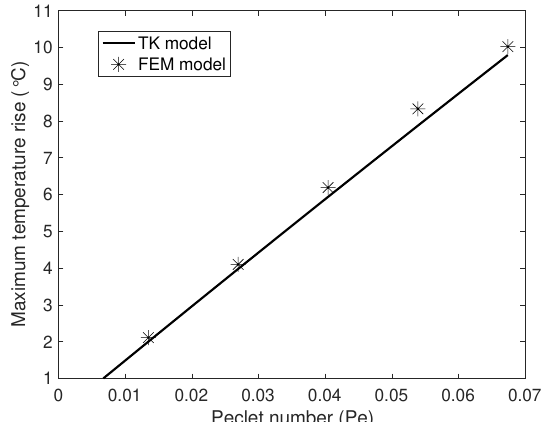
Figure 4 . Maximum temperatures estimated from the theoreti- cal (TK) model and the FEM model at di ff erent values of Peclet number (sliding velocity)